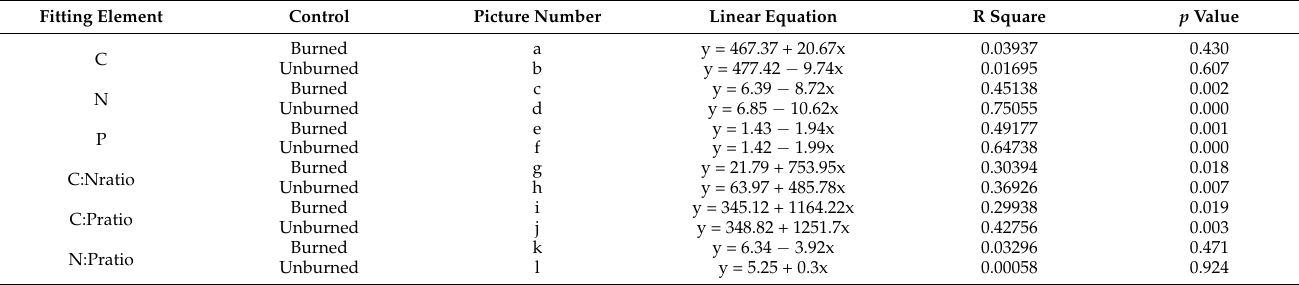
Table A3. Linear Fit of Decomposition Rate k and Litter